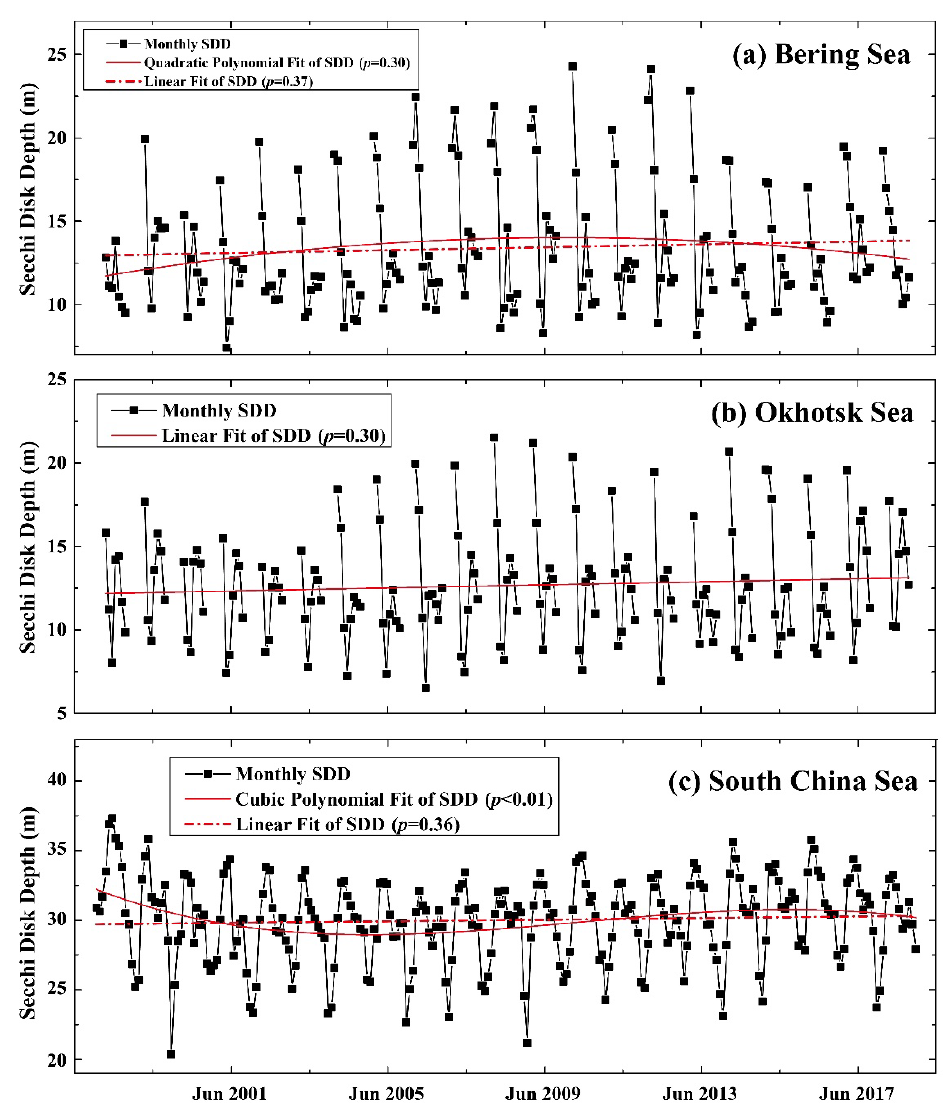
Figure 6. Time series of SDD in the ( a ) Bering, ( b ) Okhotsk, and ( c ) South China Seas during 1998– 2018.